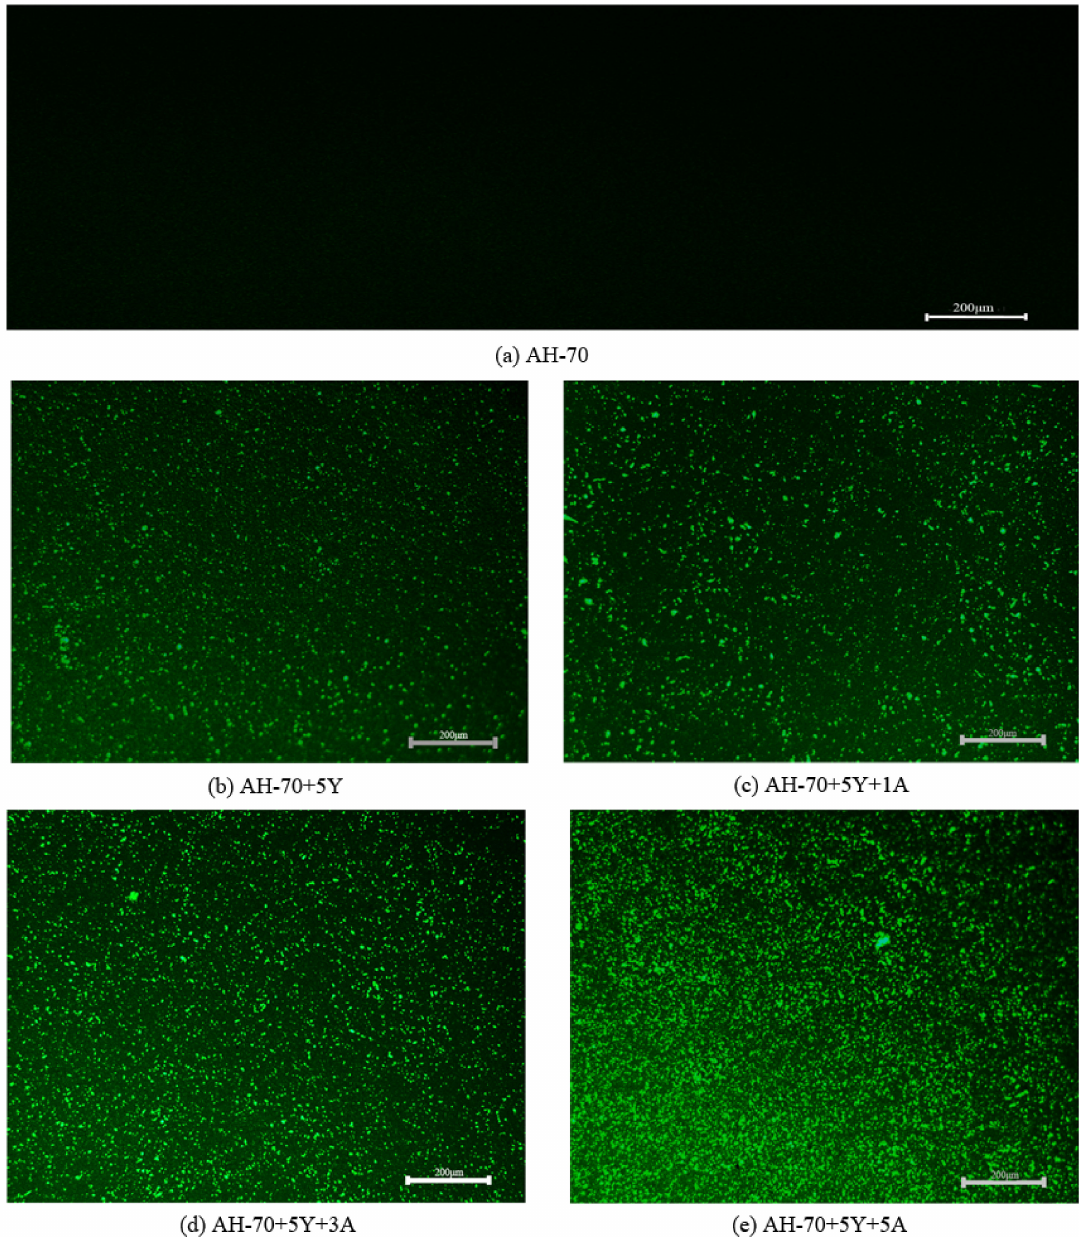
Figure 1. FM of A-Pal-compounded styrene-butadiene-styrene (SBS)-modified asphalt (400 × ): ( a ) AH-70; ( b ) AH-70+5Y; ( c ) AH-70+5Y+1A; ( d ) AH-70+5Y+3A; ( e )